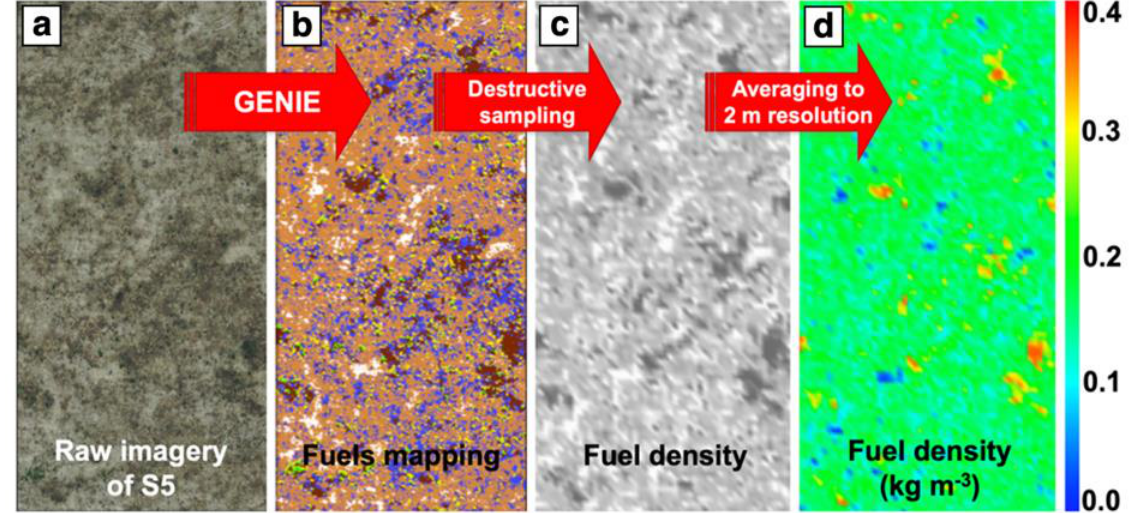
Figure 2. Flow chart for processing of ( a ) raw 0.15 m imagery through ( b ) fuels classification mapping using the Genie software at 0.15 m resolution, ( c ) associating fuel properties from destructive sampling with each pixel from the Genie-based classification and ( d ) building fuel data such as fuel density at 2 m × 2 m resolution for use in FIRETEC.